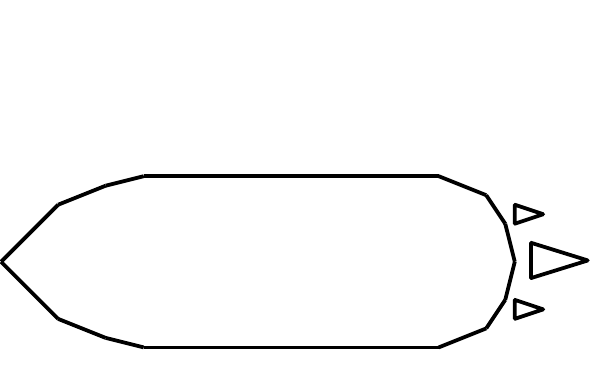
Figure 18: An example of a possible set of intersection polygons between the floe’s top face plane and the mesh of the vessel.